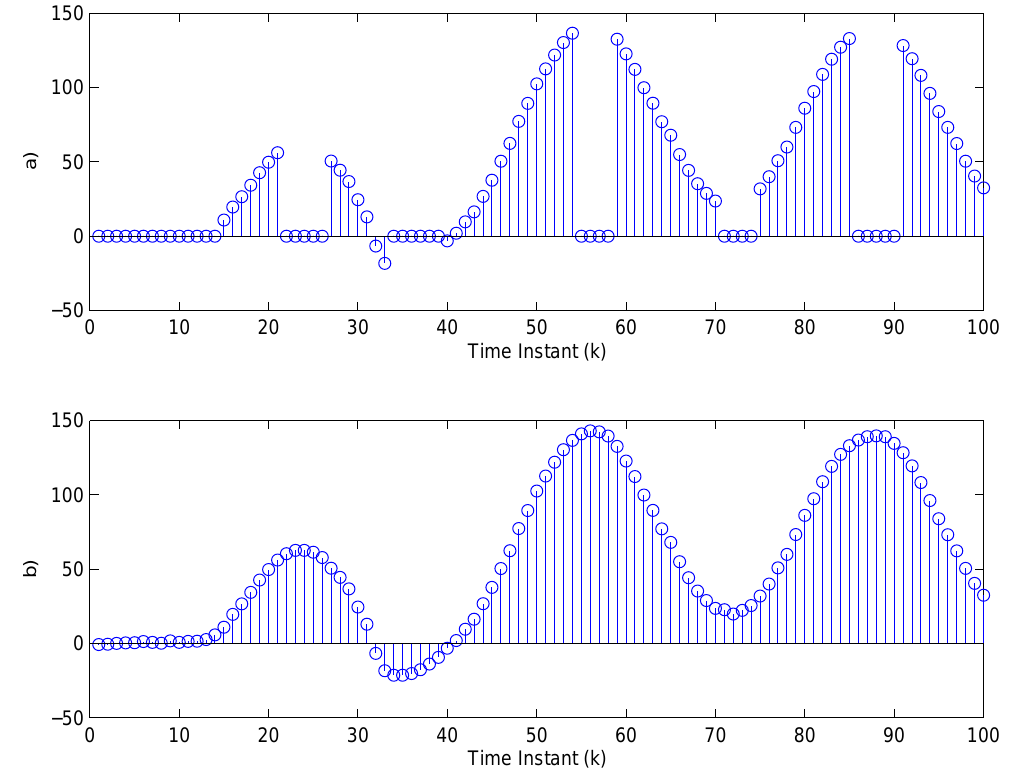
Figure 5. Transmitted measurements of sensor y 1 (b)